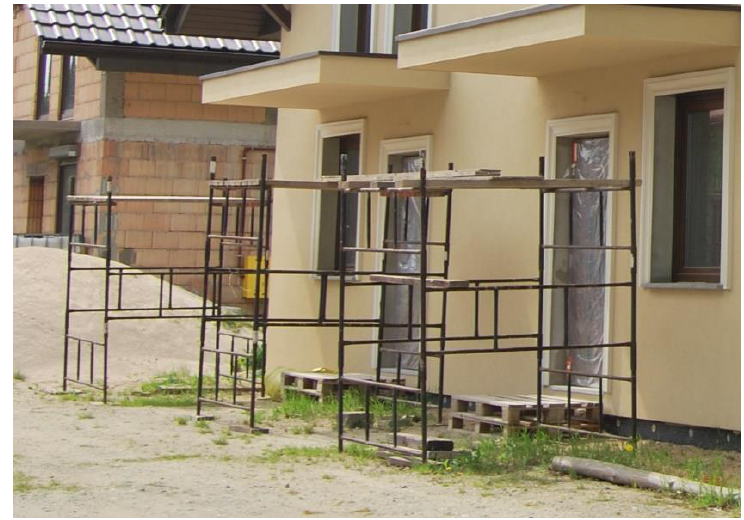
Figure 1. The example of the Warsaw-type scaffolding (author’s archive).